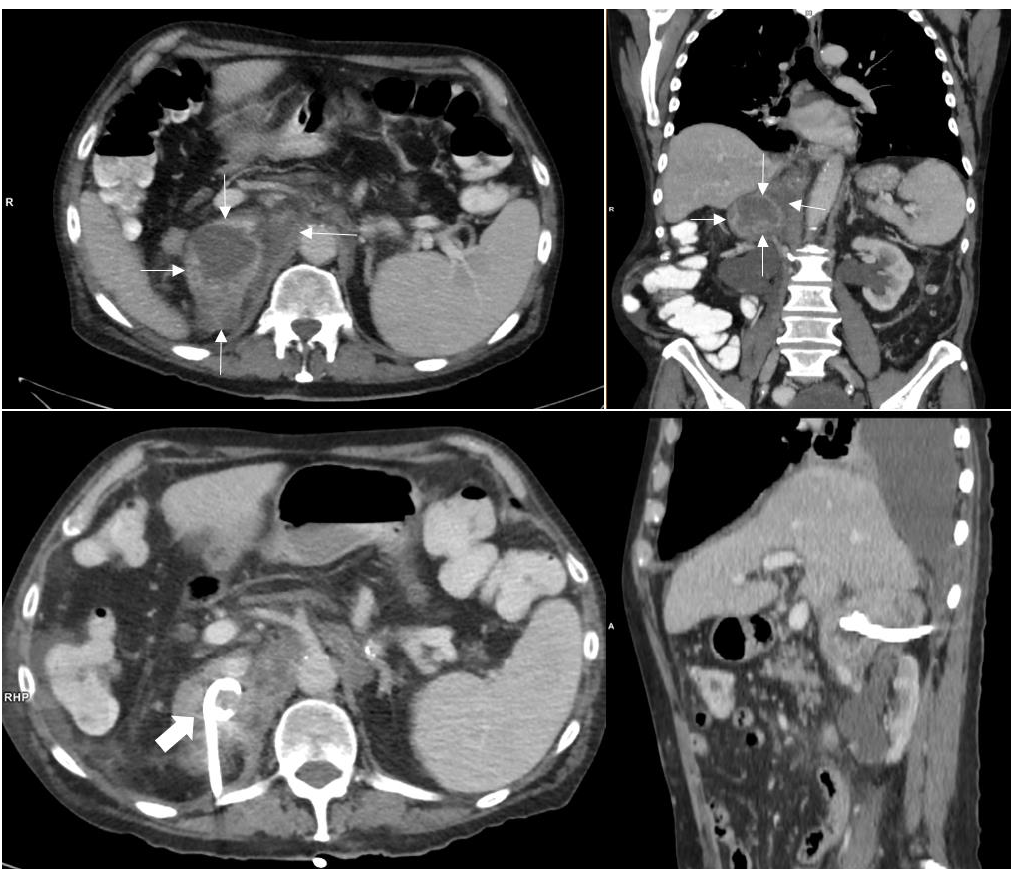
Figure 1. Upper row : 11 × 6 cm retroperitoneal mass in the right adrenal loge (thin white arrows) with contact to diaphragm, liver and retroperitoneal vessels. The pararenal space is not involved. The mass shows an inhomogeneous enhancement. The right adrenal gland itself cannot be distinguished. Lower row : Mass after puncture and CT guided drainage with a pigtail catheter (thick white arrow).